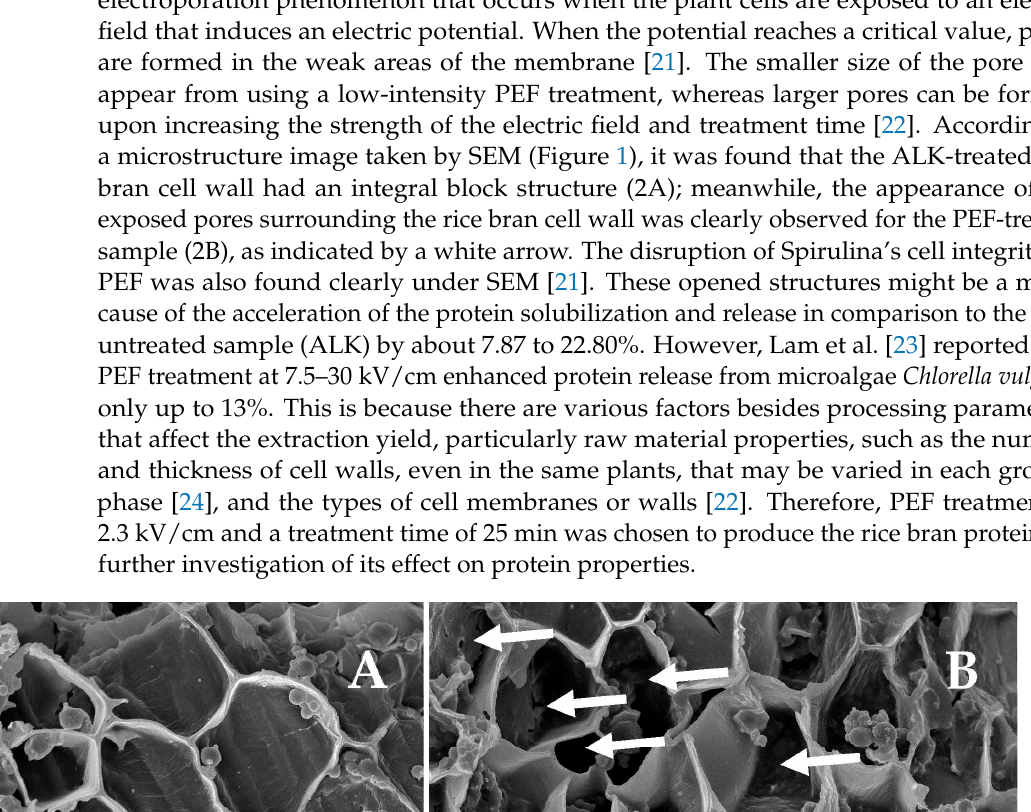
Figure 1. Rice bran characteristics treated by ALK ( A ) and PEF ( B ) treatments under SEM (×1000).